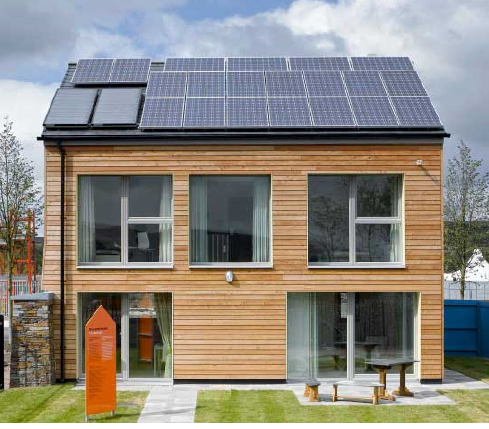
Figure 1. Larch House in Ebbw